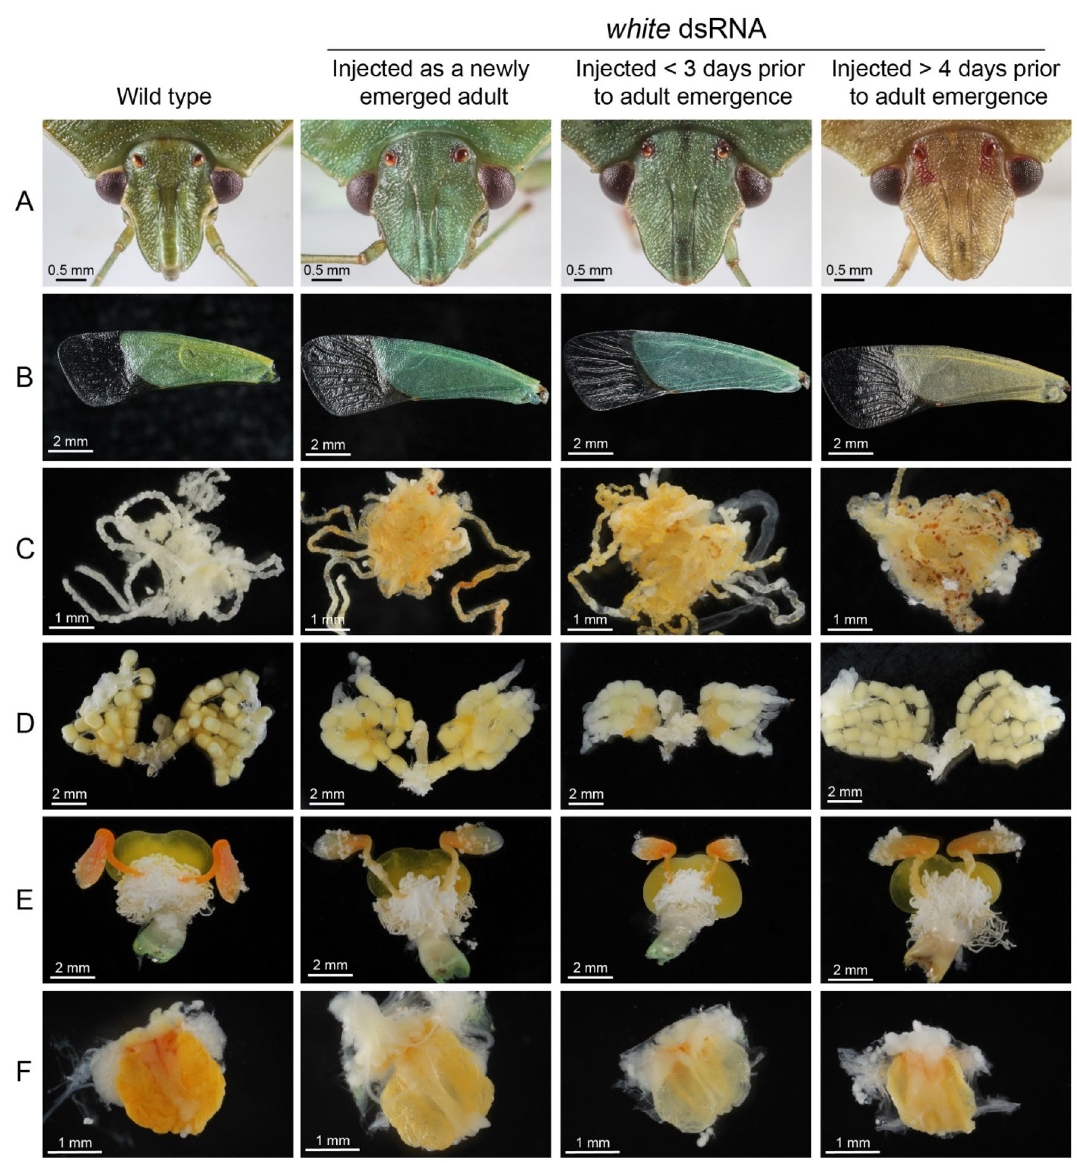
Figure 2. Phenotypes observed in 30 days-old SGSB adults following RNAi-based microinjections relative to wild type. Figure shows ( A ) head displaying compound eyes and ocelli; ( B ) forewing; ( C ) Malpighian tubules; ( D ) female gonads; ( E ) male gonads; and ( F ) metathoracic scent